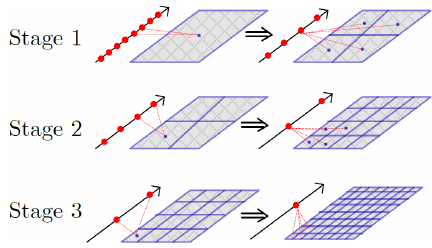
Figure 2. Schematic illustration of the FFBP with eight apertures and three factorization stages. In each processing stage, a common factorization factor of two is used. Narrower “new” beams are formed based on wider “old” beams formed in the previous stage. In the first stage, each of two adjacent subapertures forms a new beam, and 2 × 2 beams are obtained. In the second stage, repeat the summation operation of Stage 1, and 4 × 4 beams are